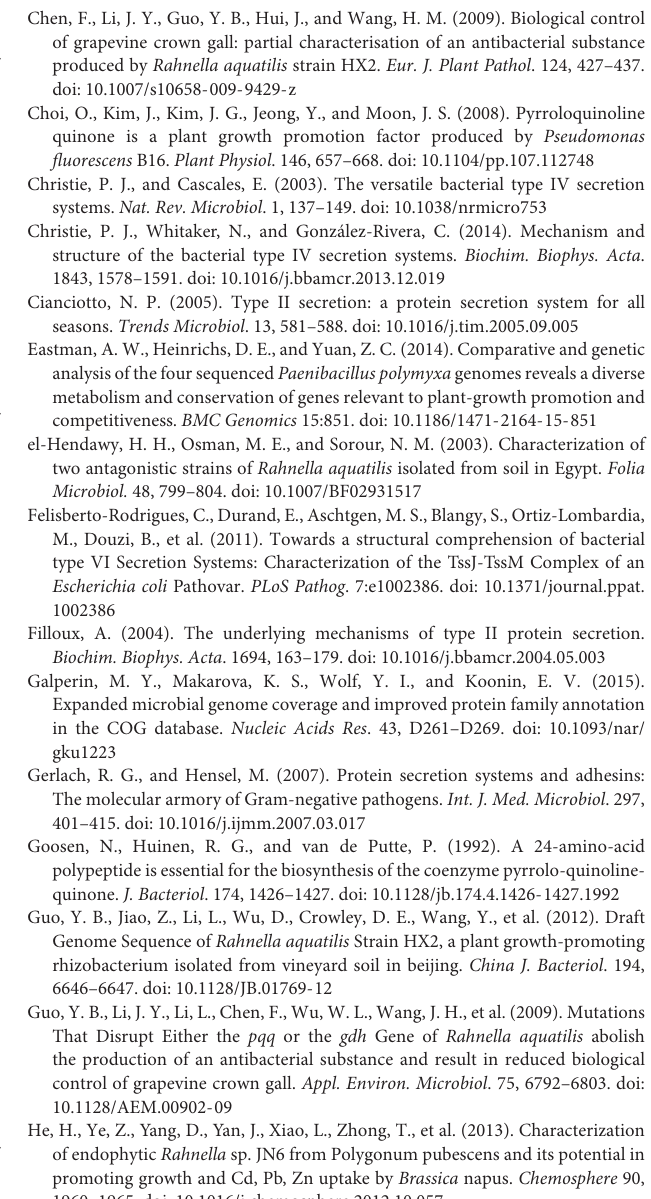
Supplementary Figure 2 | Production of extracellular enzymes and siderophores by R. aceris ZF458. Plate assays for the production of siderophores (A) and phosphatases (B) . Supplementary Figure 3 | General characteristics of R. aceris ZF458. (A) Image of ZF458 colony morphology. (B) Image of ZF458 cells using transmission electron microscopy (Hitachi 7700, Japan). (C) Image of ZF458 cells using scanning electron microscope (Hitachi S3400N, Japan). Supplementary Figure 4 | Growth curve aND pH curve of R. aceris ZF458 for different culture times. (A) Optical density of ZF458 at different culture times, (B) pH of ZF458 at different culture times. Supplementary Figure 5 | Phylogenetic tree highlighting the relative positions of R. aceris ZF458 among other Rahnella strains. The phylogenetic tree was constructed based on four housekeeping genes (16S rRNA, gyrB , atpD , and